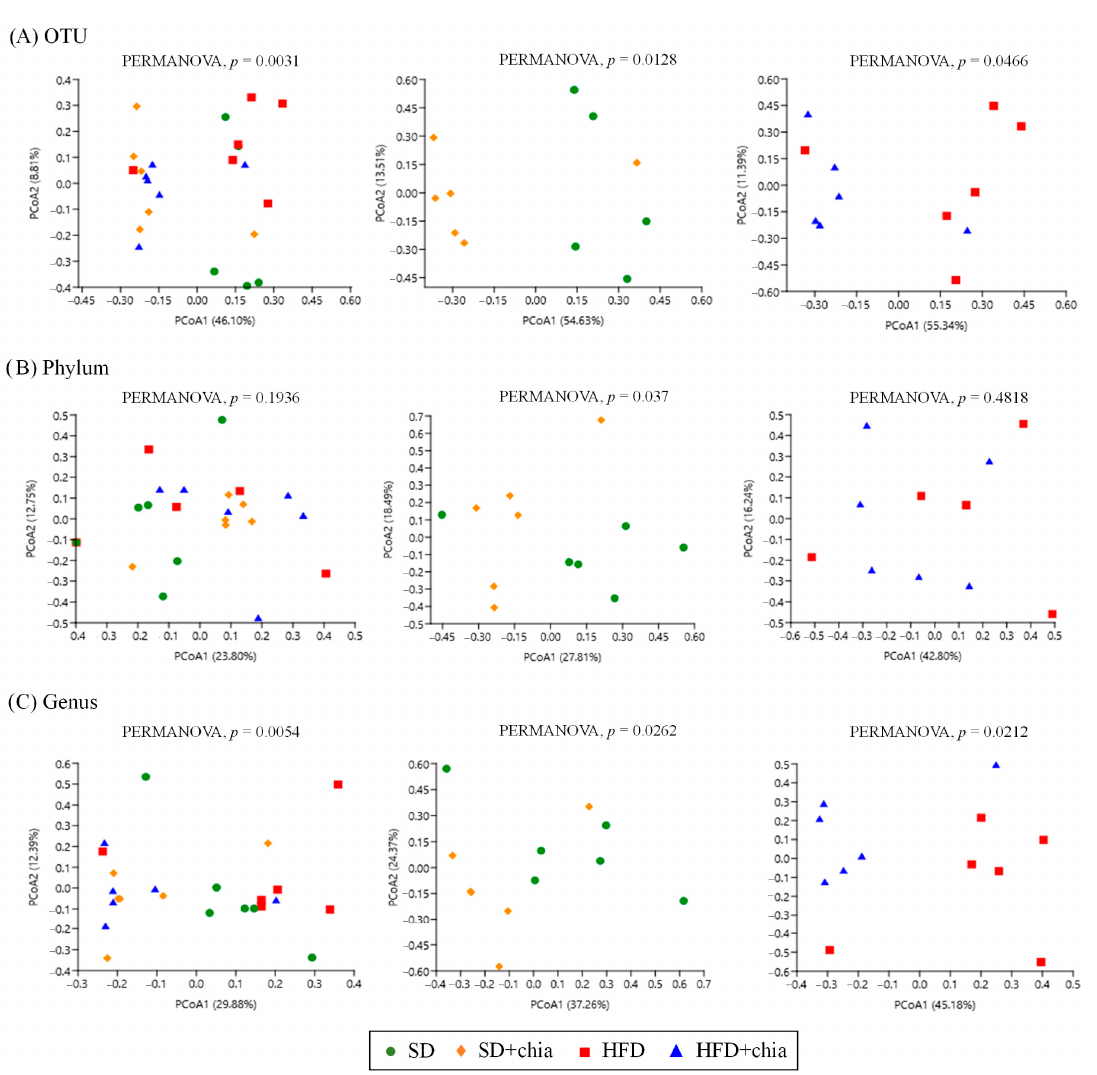
Figure 3. Changes in β -diversity of the cecal microbiome of young Wistar rats after 35 days of treatment. ( A ) Principal Coordinate Analysis (PCoA) based on the Jaccard distance at OTU level. ( B ) Principal Coordinate Analysis (PCoA) based on Jaccard distance at phylum level. ( C ) Principal Coordinate Analysis (PCoA) based on Jaccard distance at genus level.